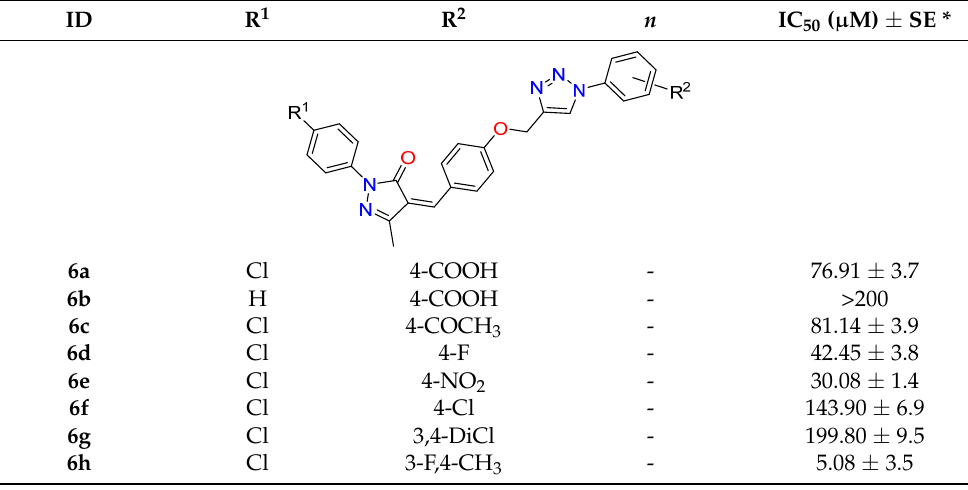
Table 1. SAR e ff ect against SARS-CoV-2 Main protease for the novel